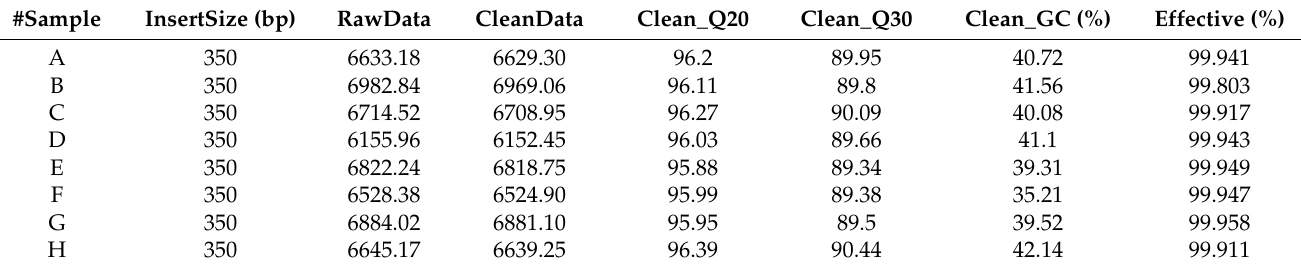
Table 1. Data preprocessing statistics table.